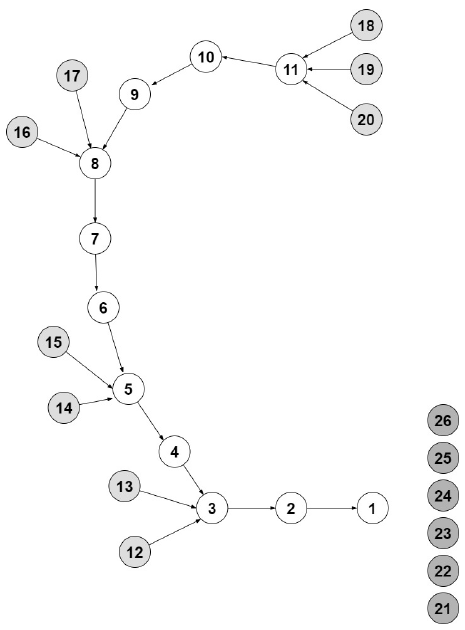
Figure 4. Initial